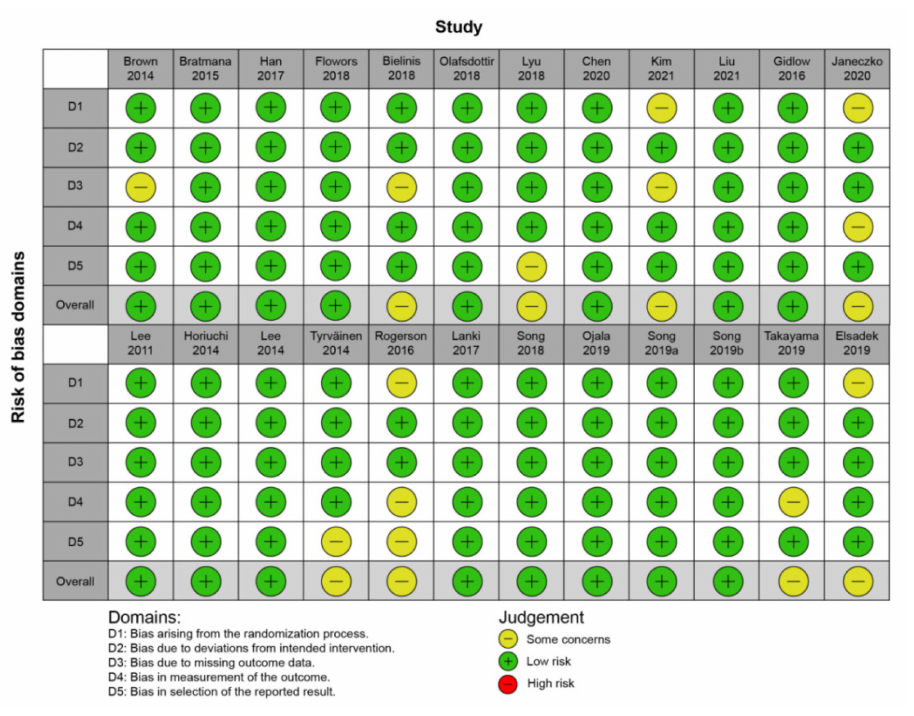
Figure 2. Methodological quality of included studies